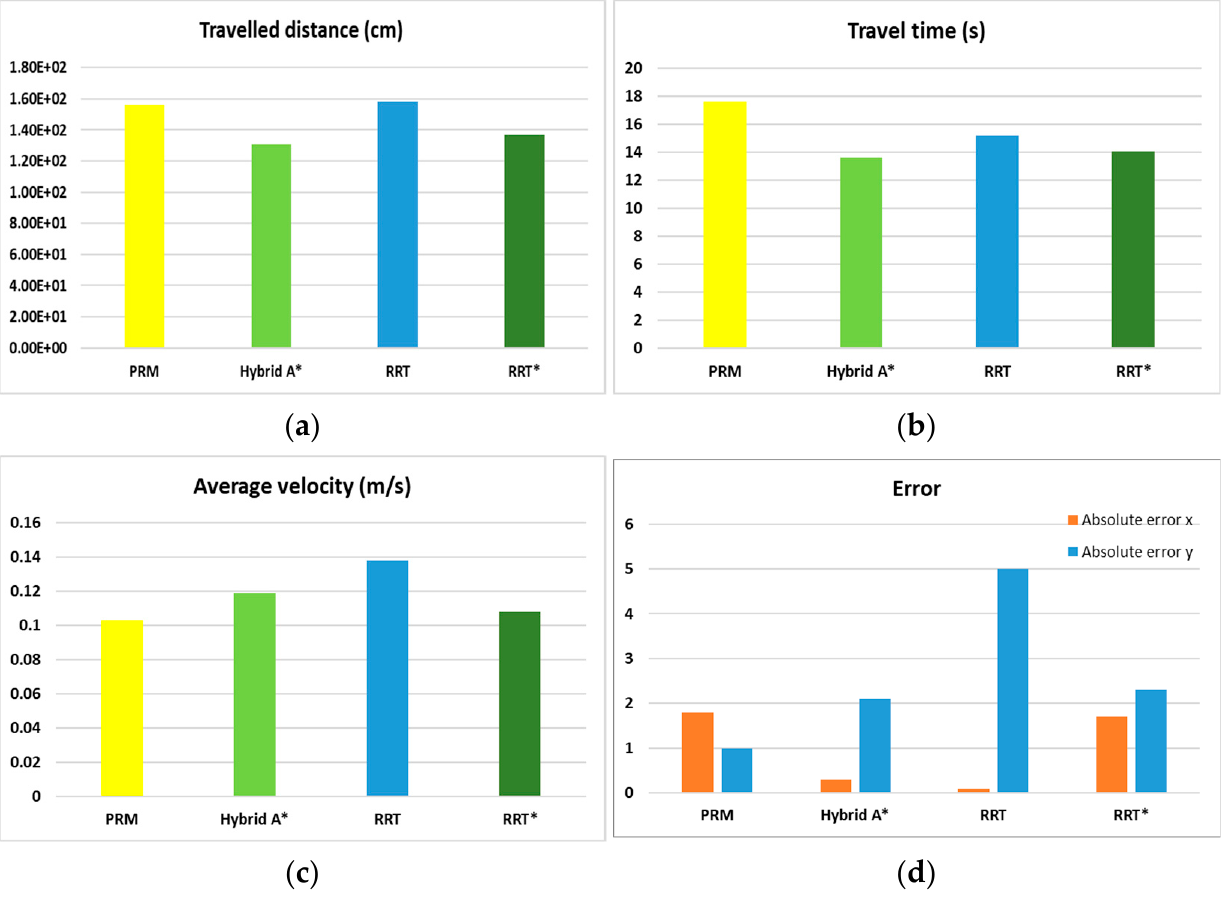
Figure 10. The experimental results that are generated by using different path-planning techniques in Map1. ( a ) The resultant traveled distance for different path planning techniques ( b ) The resultant average velocity for different path planning techniques ( c ) The resultant travel time for different path planning techniques ( d ) The resultant absolute error for different path planning techniques.